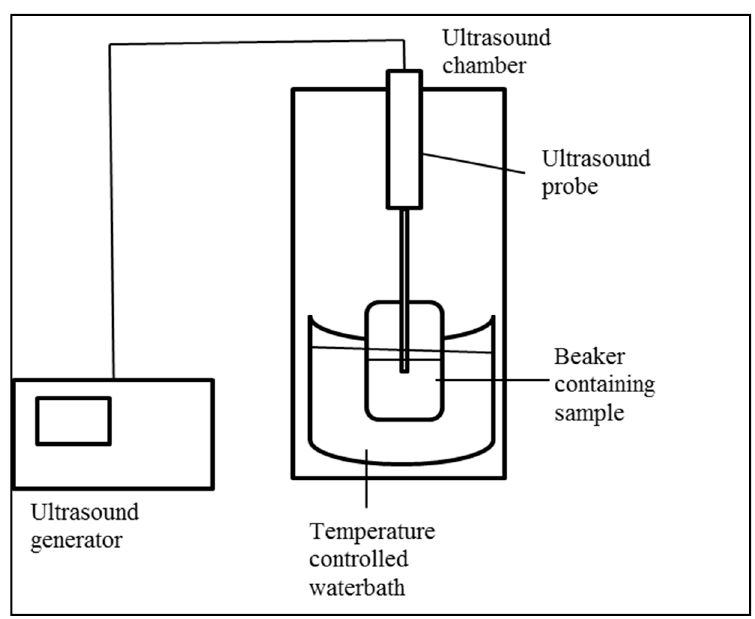
Figure 1. Ultrasound-assisted extraction set-up.